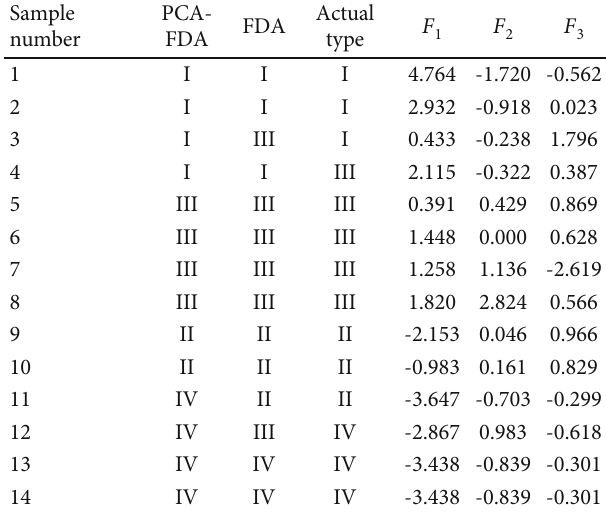
Table 6: Identi fi cation results of training